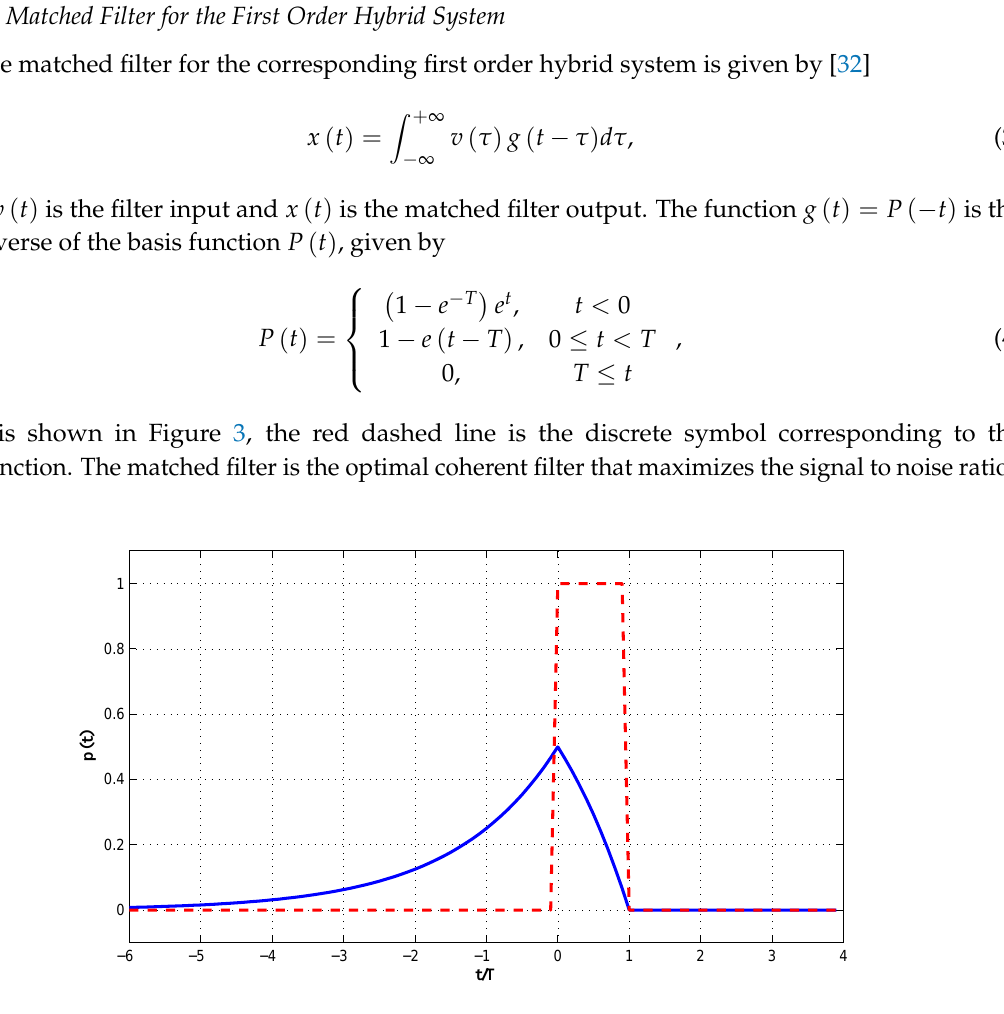
Figure 3. Basis function and discrete